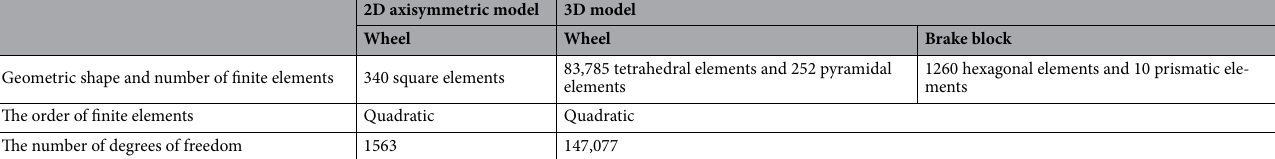
Table 4. Parameters of geometric models and applied finite